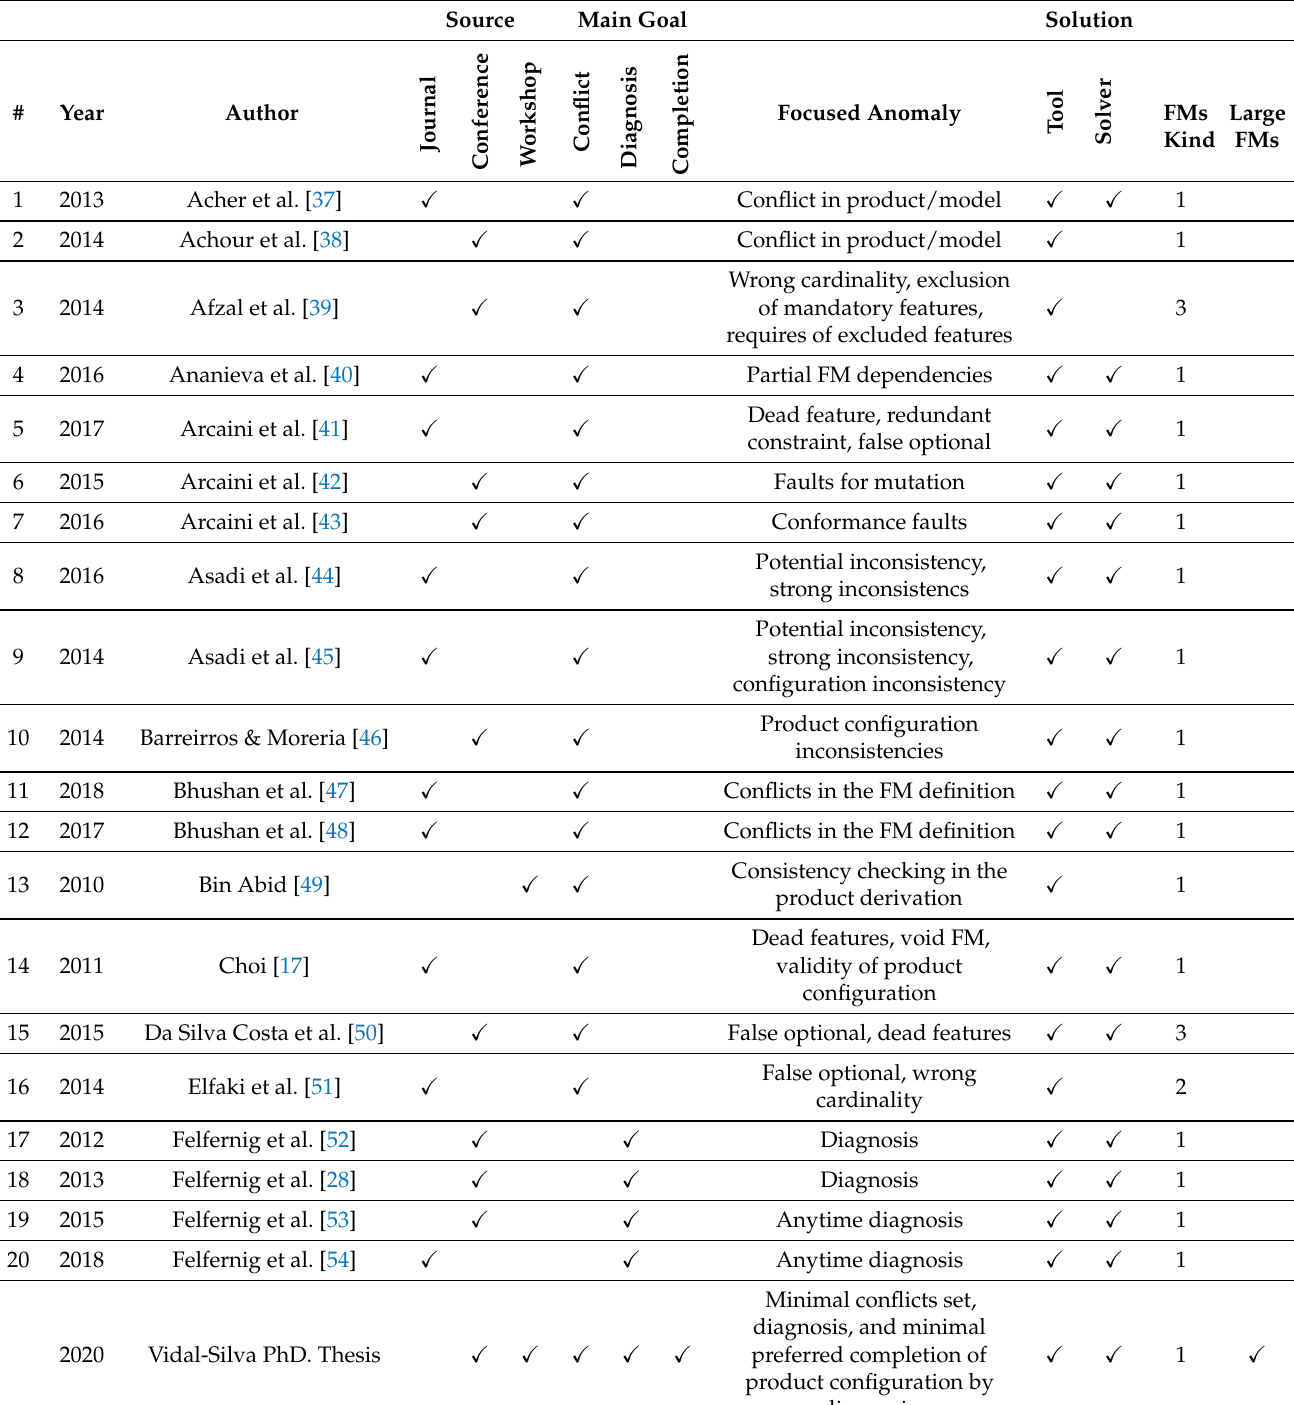
Table 2. List of articles ordered by the authors’ last name from A to F in the SLR vs. our thesis work. Source Main Goal